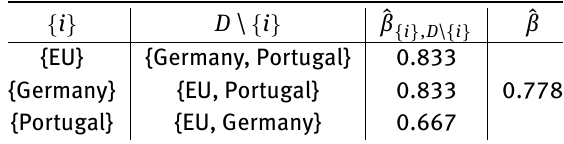
Table 1: Estimates of the bivariate coefficients β { i } , D \ { i } and of the multivariate medial correlation coefficient β of the annual main GDP aggregates per capita in the European Union, Germany and Portugal, from 2008 to 2019.